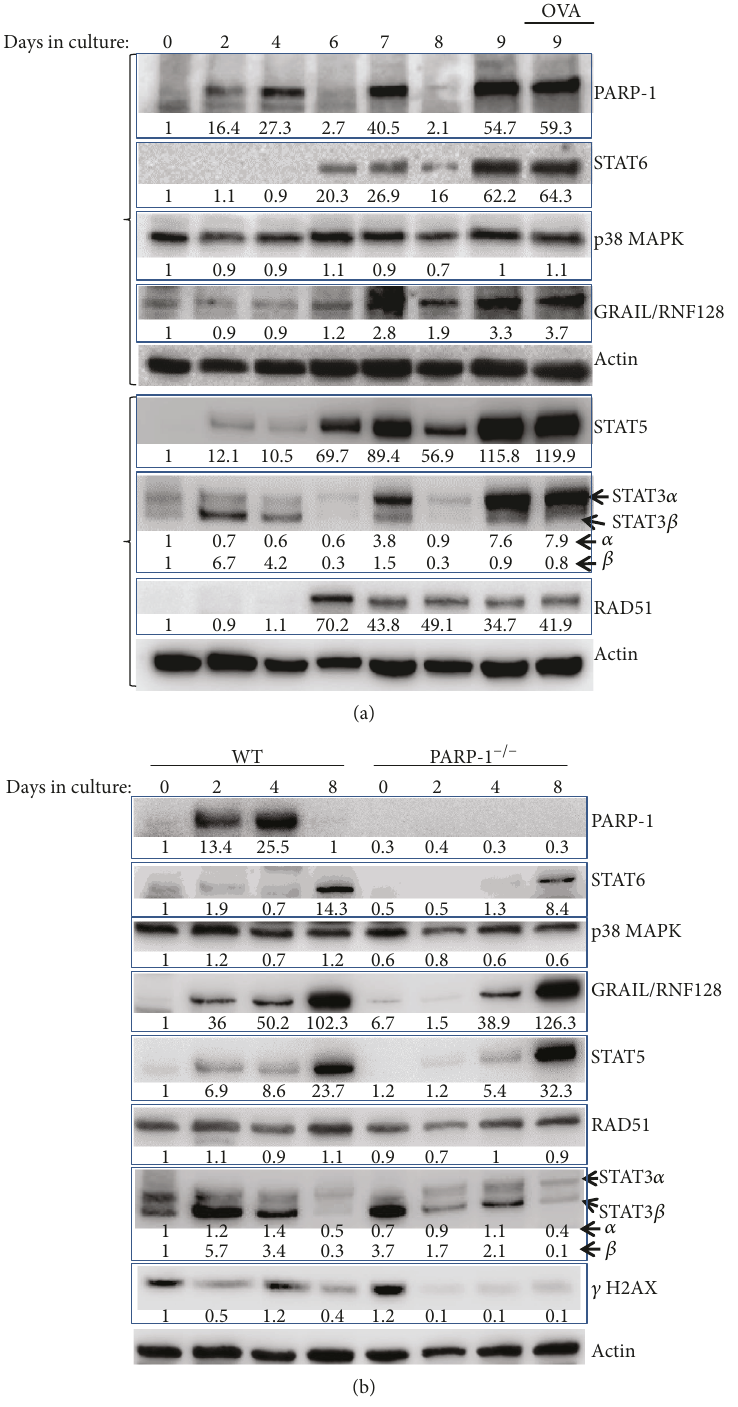
Figure 1: Bone marrow progenitors were isolated from C57BL/6 mice and incubated with 20ng/ml GM-CSF. (a) Cells were collected at days 0, 2, 4, 6, 7, 8, or 9. A portion of the cells at day 8 were stimulated with OVA for 24h. Collected cells were processed for protein extraction followed by immunoblot analysis with antibodies to the indicated proteins. Blots were stripped of antibodies prior to probing with the next one. The two braces on the left represent two di ff erent gels of the same samples. (b) Bone marrow progenitors from WT or PARP-1 − / − mice were isolated and processed as in (a). Protein extracts were subjected to immunoblot analysis with antibodies to the indicated proteins. For (a, b), signals were quanti fi ed and are shown as values under the respective